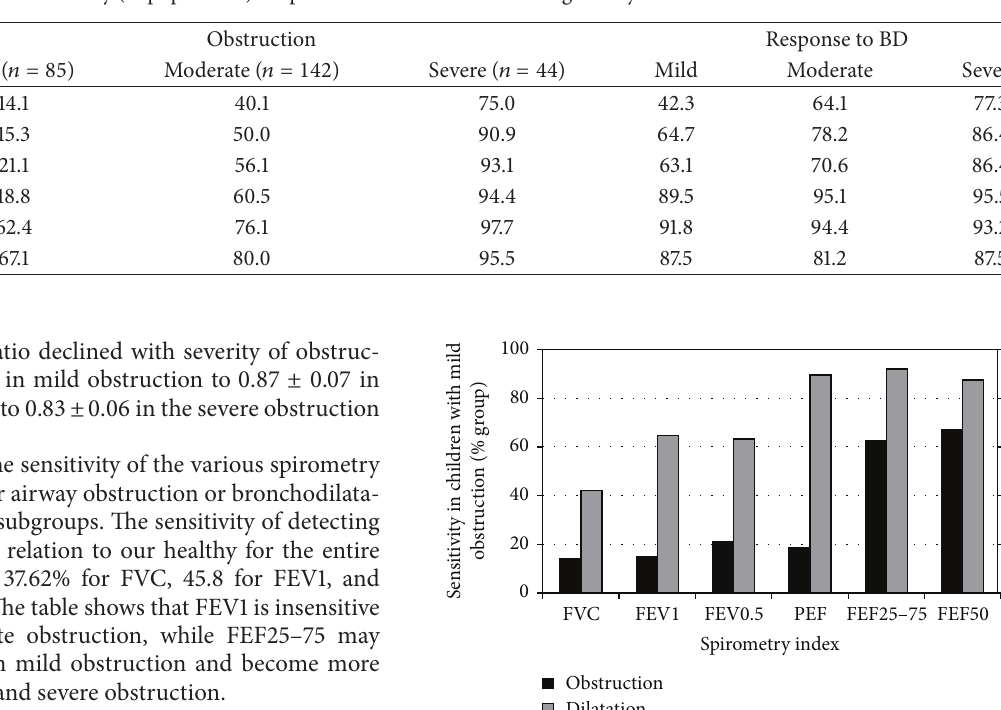
Table 2: Sensitivity (% population) of spirometric indices for detecting airway obstruction or dilatation.